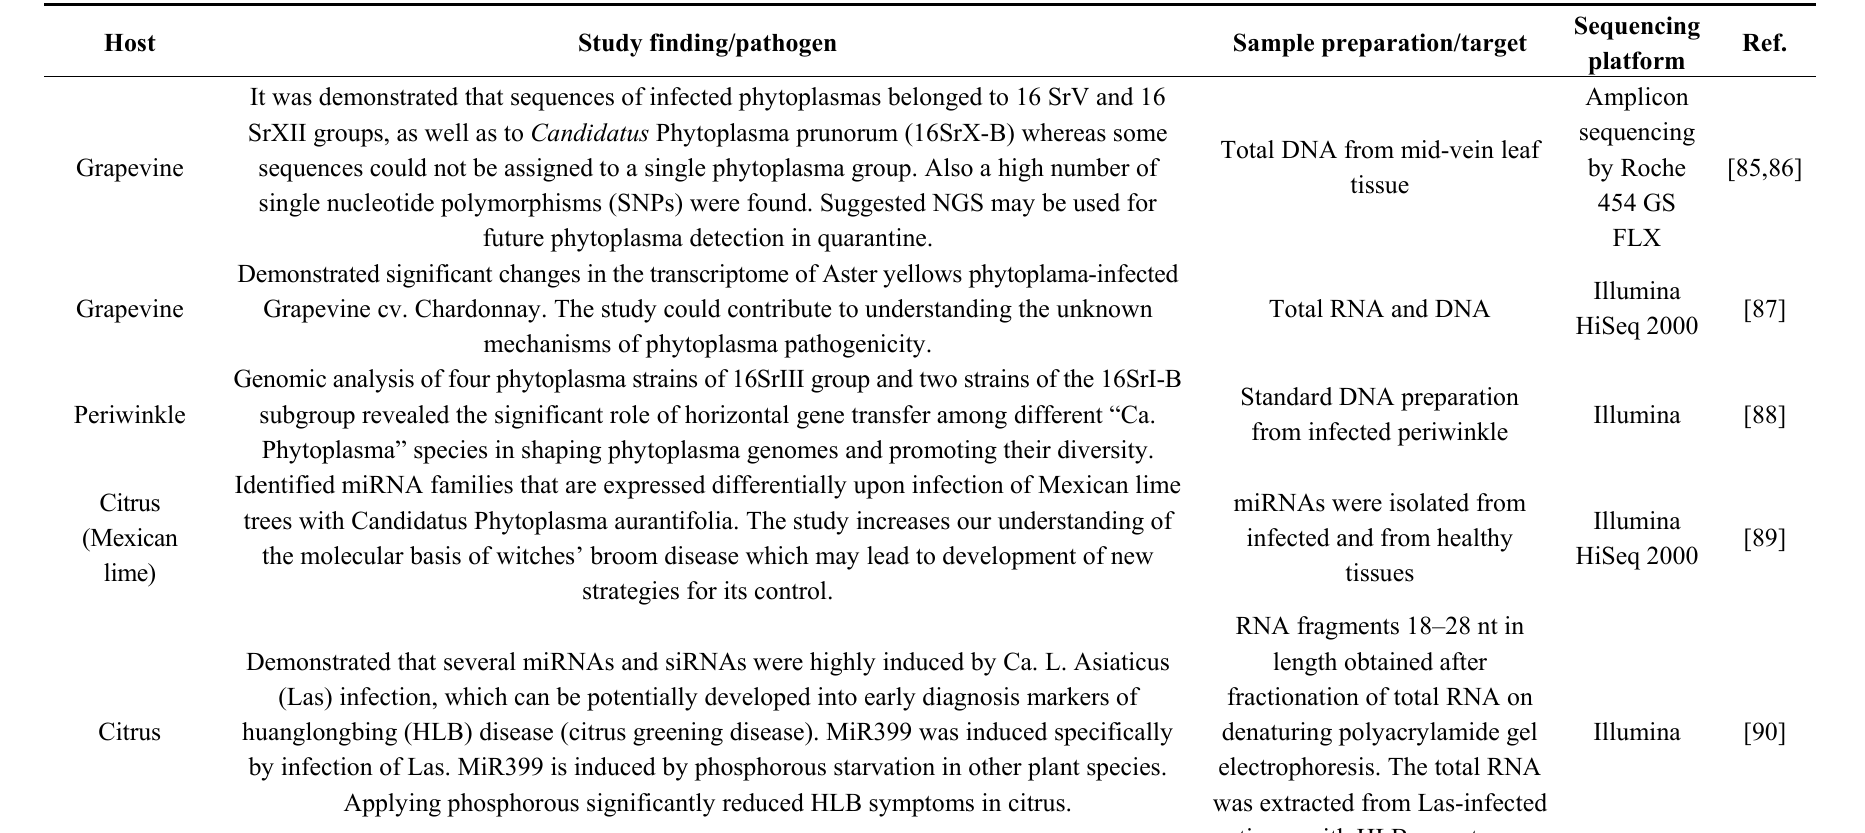
Table 8. Next-generation sequencing of isolated DNA, RNA or miRNA from grapevine, periwinkle or citrus infected with phytoplasmas or difficult to culture